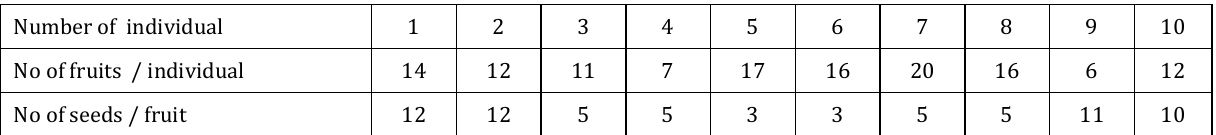
Table 2. The generative organs structure (sexual reproduction characteristics) of individuals within the newly described population of S. amplexifolius (authors)